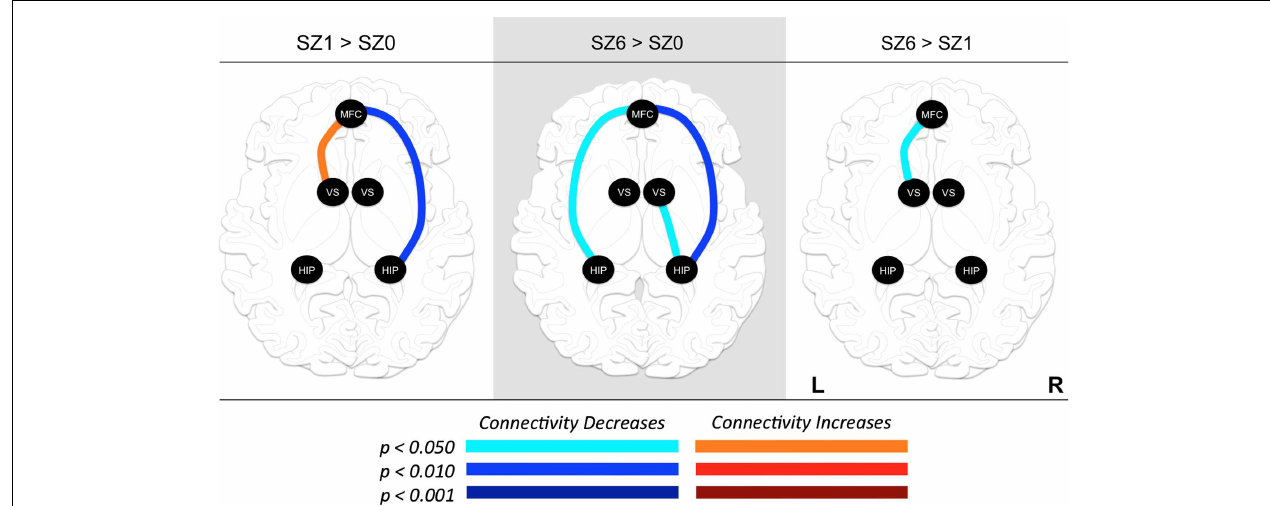
edge color indicates the significance of the connectivity change between nodes (p-value), for all connections with p < 0.05. SZ0, baseline; SZ1, 1week of antipsychotic drugs treatment; SZ6, 6weeks of antipsychotic drug treatment; HIP, hippocampus;VS; ventral striatum/nucleus accumbens; MFC, medial frontal